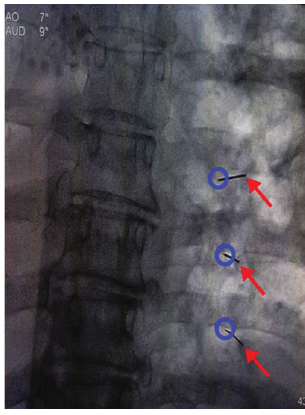
Figure 2 - The setup of the Two-point group. The red arrows refer to the puncture needles. The blue circles are shown as the lesion point, and the green circles are shown as the anesthesia point.